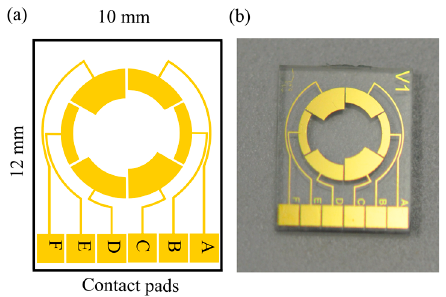
Figure 2. ( a ) Schematic view of the sensor design with various electrode configurations (AD, BE, CF) used for the measurements of impedance changes in the culture medium due to the mold growth; ( b ) optical image.